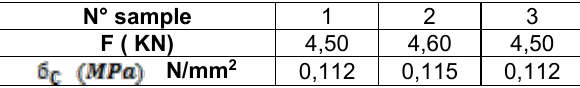
Table 9. Results of compression experiment for concrete blocks